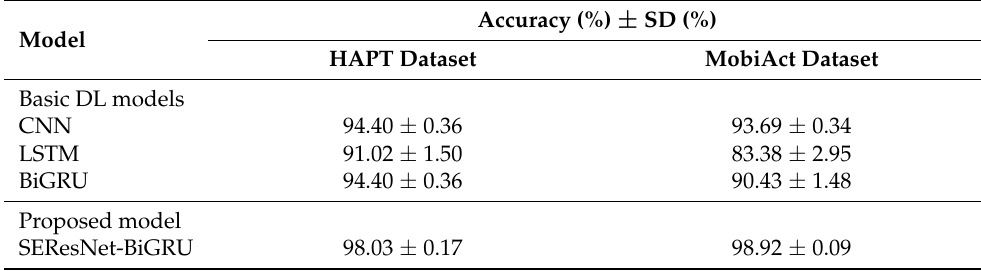
Table 6. Experimental findings of different DL models.